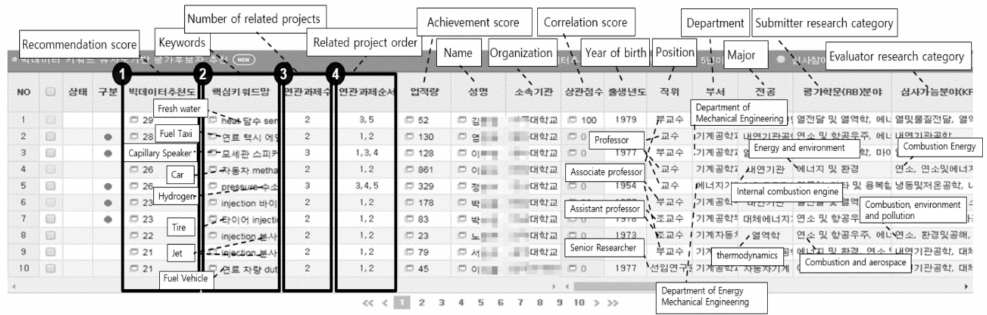
Figure 3. The output of the big data valuation recommendation system.